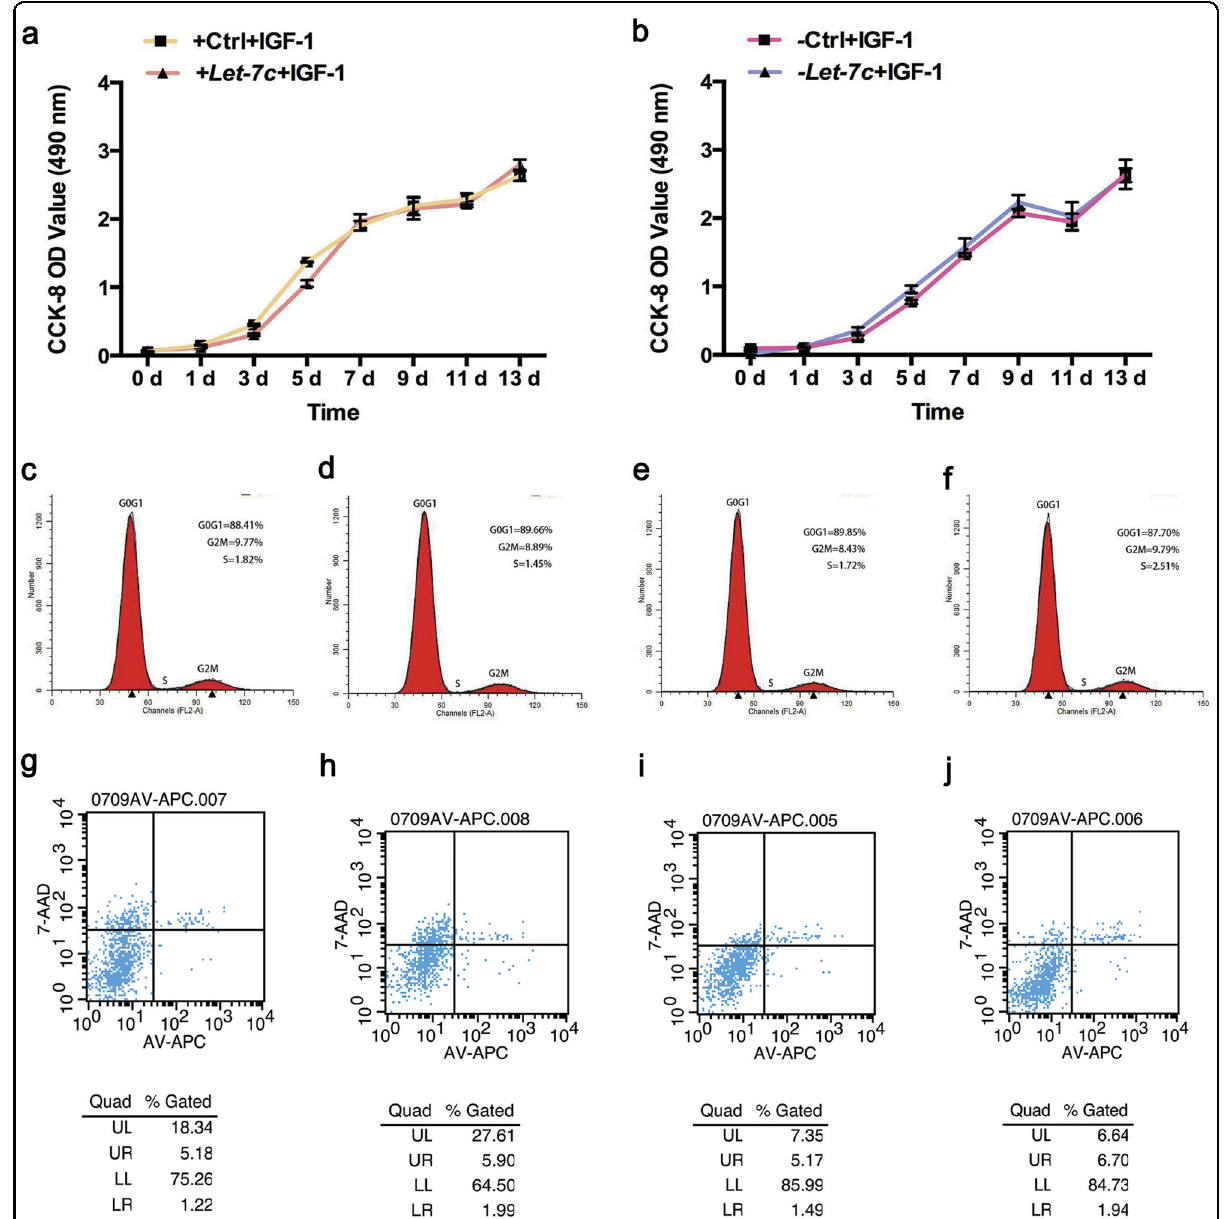
Fig. 3 Effects of let-7c on the proliferation of IGF-1-treated DPMSCs. a , b CCK-8 assay revealed no signi fi cant differences between the growth curves of + Let-7c DPMSCs and + Ctrl DPMSCs ( a ) or between those of – Let-7c DPMSCs and – Ctrl DPMSCs ( b ). Values are presented as the mean ± SD, n = 3. c – f Flow cytometry was used to assess proliferative capabilities. The average proliferation index (PI = S + G2M) in + Ctrl DPMSCs ( c ), +